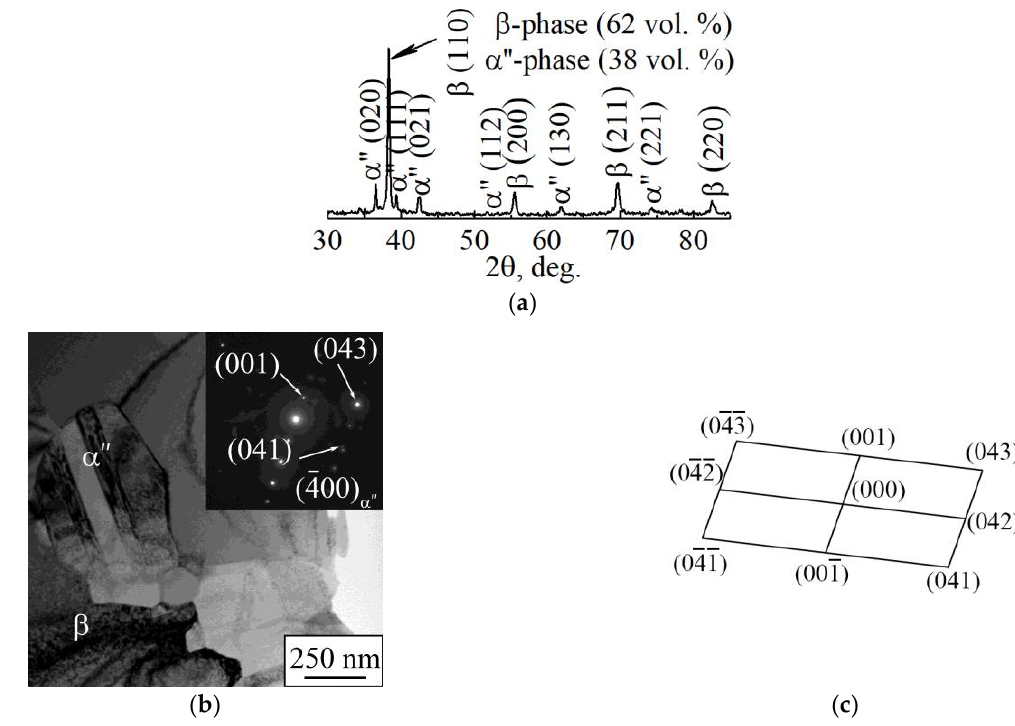
Figure 9. ( a ) XRD pattern, ( b ) light-field TEM-image with corresponding SAED pattern, and ( c ) phase identification scheme of LPBF dense sample.